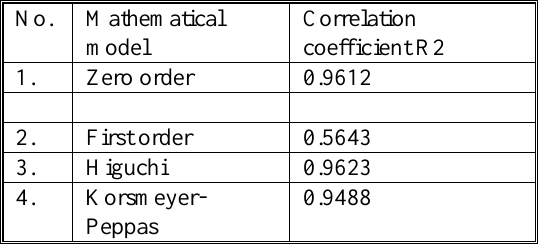
Table 10. Mathematical Models Correlation